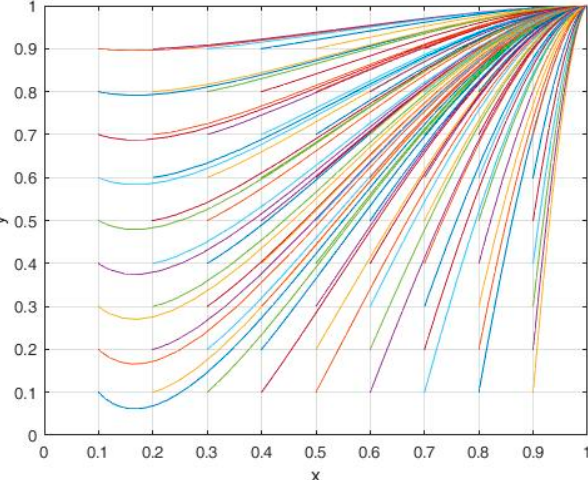
Figure 3. The dynamic evolutionary diagram of the system.